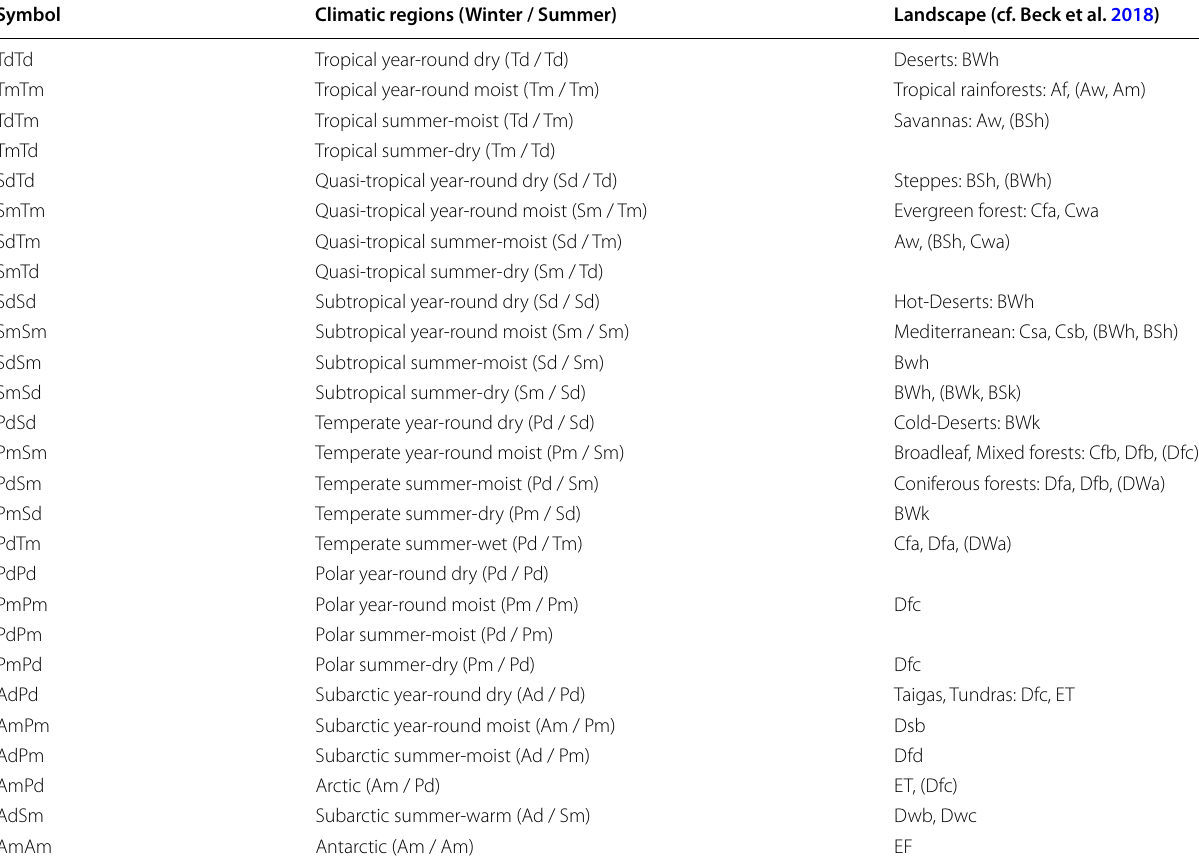
Table 3 Twenty‑seven climatic regions and their correspondence to the KGCC